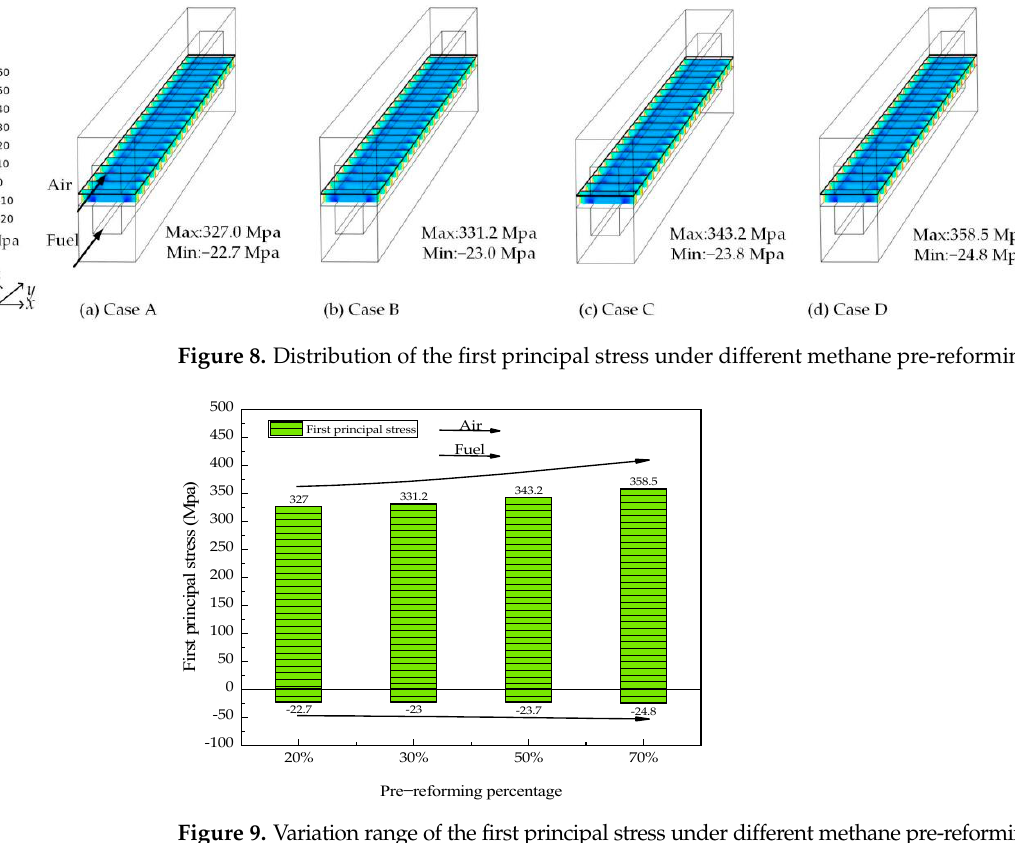
Figure 10. Distribution of MSR reaction rate for case C.